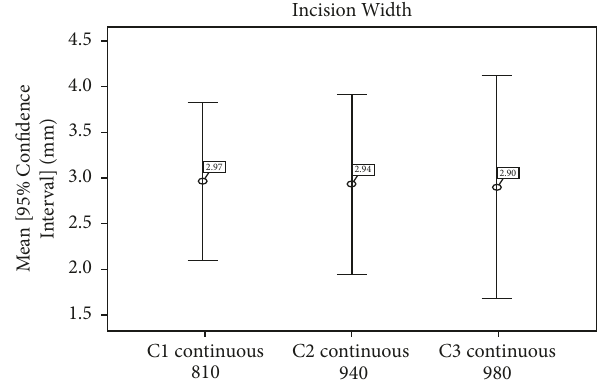
was the lowest with C2 and equal with C1 and C3 (Figure